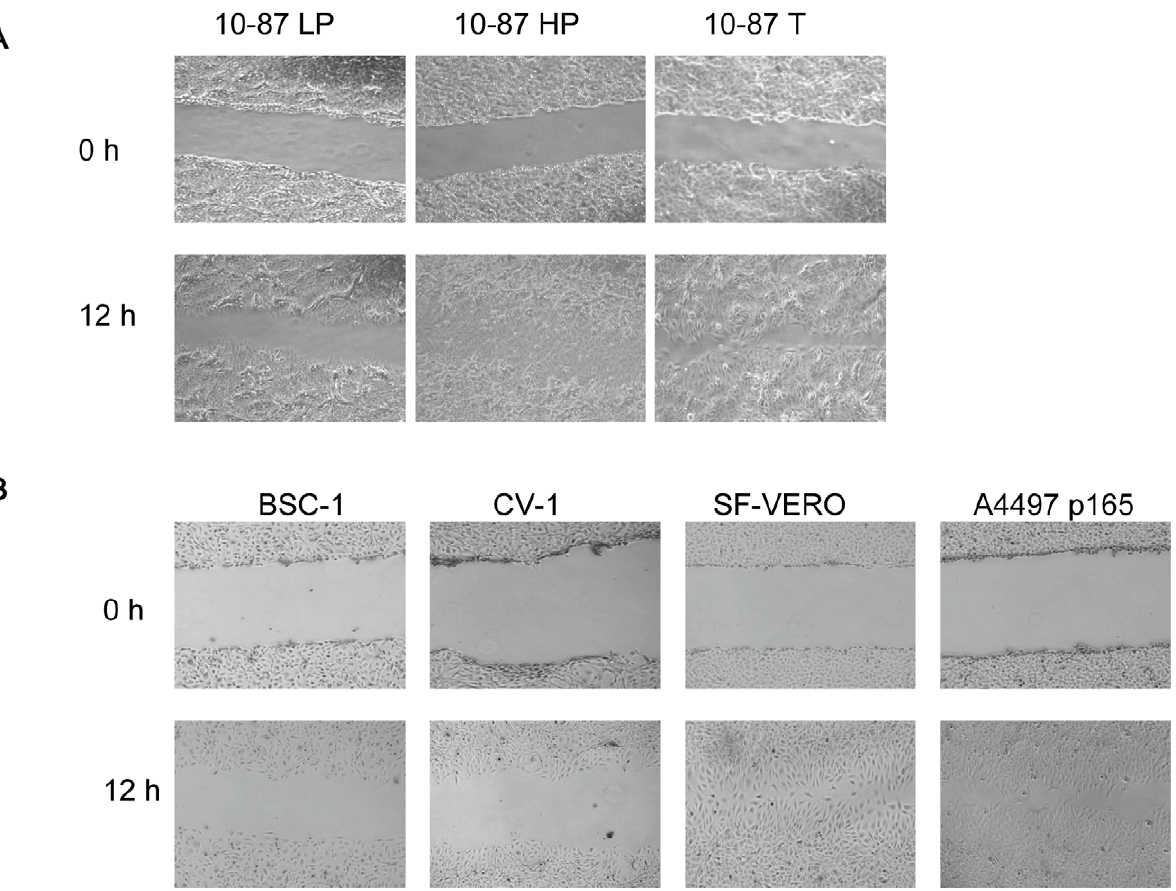
Figure 1. Wound-healing assay using African green monkey kidney cell lines. (A) 10-87 LP, 10-87 HP and 10-87 T. (B) BSC-1, CV-1, SF-VERO, and A4497 (p165). Microscopic observations were recorded at 0, 6, 9, and 12 h after scratching the cell surface; the 0 and 12 hour images are shown. doi:10.1371/journal.pone.0014416.g001 10-87 T cells (Table 1); second, serial passage of VERO cells in migration and invasion phenotypes of 10-87 HP and 10-87 T tissue culture beyond the 10-87 LP p140 level resulted in the cells appeared to correlate with their ability to form tumors in vivo . acquisition of the potential to migrate and invade; third,